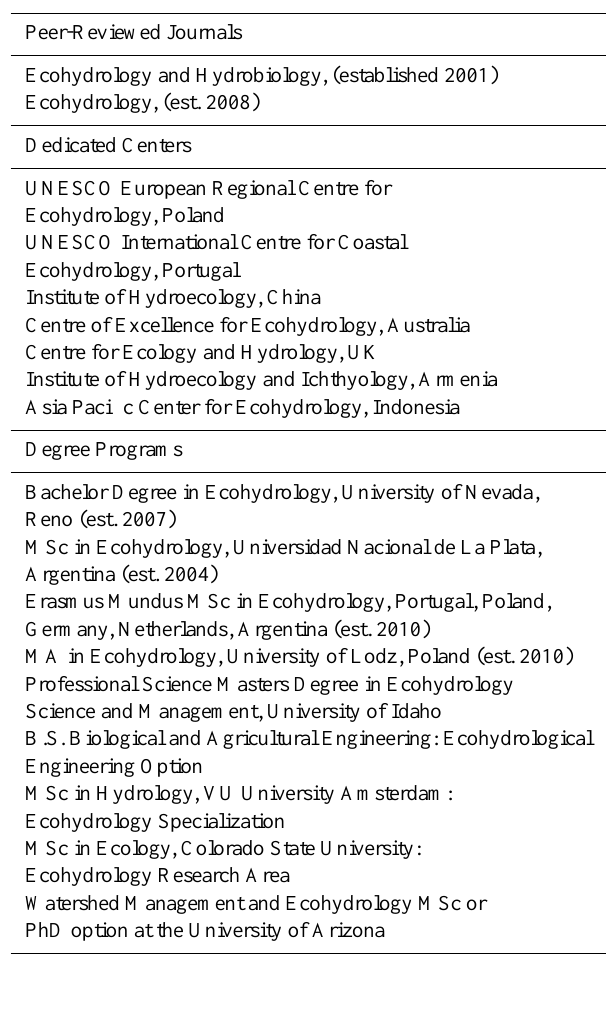
Table 1. Selection of journals, institutes, and university programs dedicated to ecohydrology. See Rickwood et al. (2010) for a more extensive